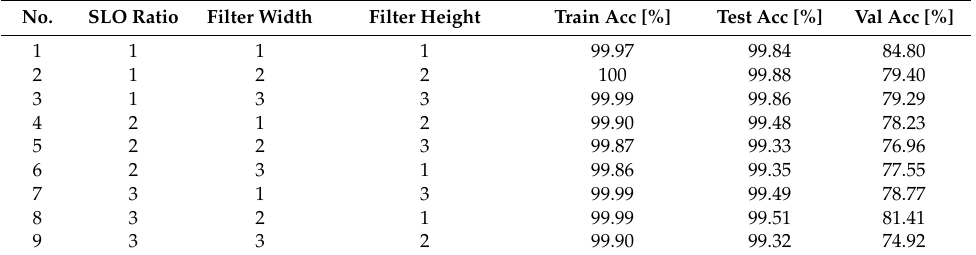
Table 3. Orthogonal array of L 9 (3 3 ) with training, test and validation accuracies by combination. No.